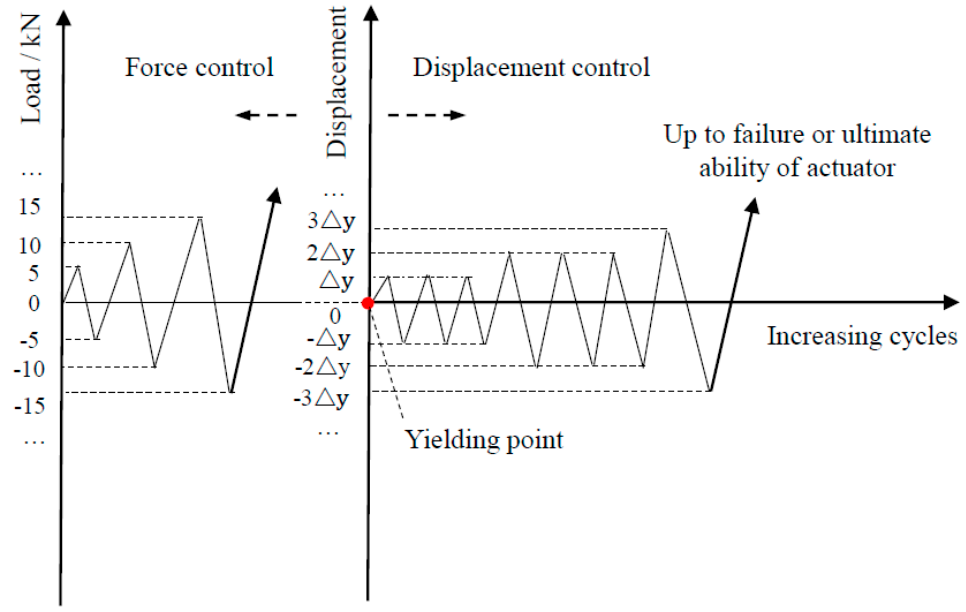
Figure 4. Lateral force-displacement history.